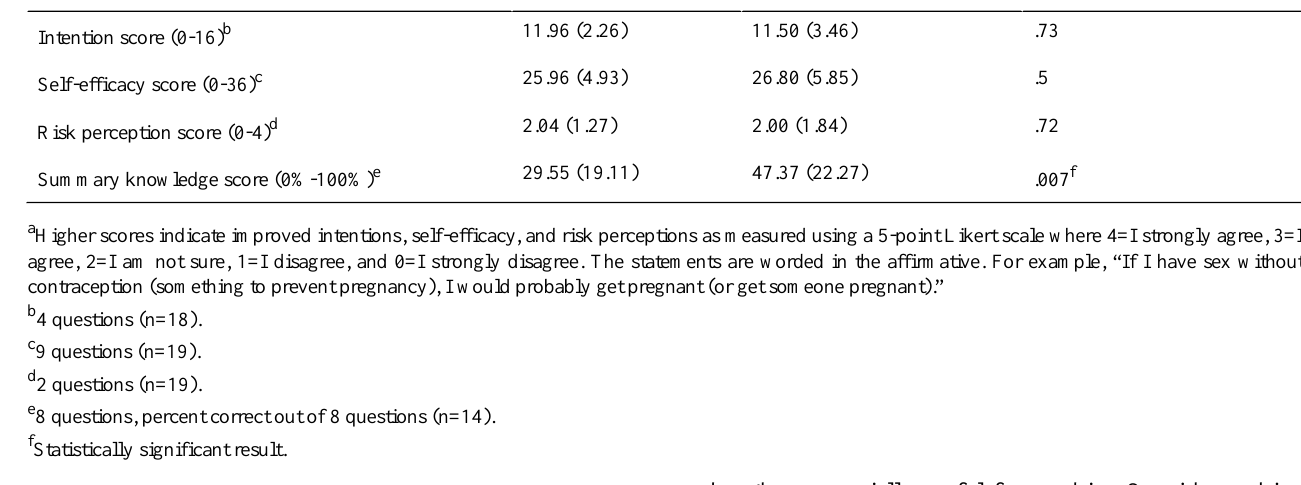
P value baseline to follow-up12-week follow-up, mean (SD)Baseline, mean (SD)Mean outcome summary scores